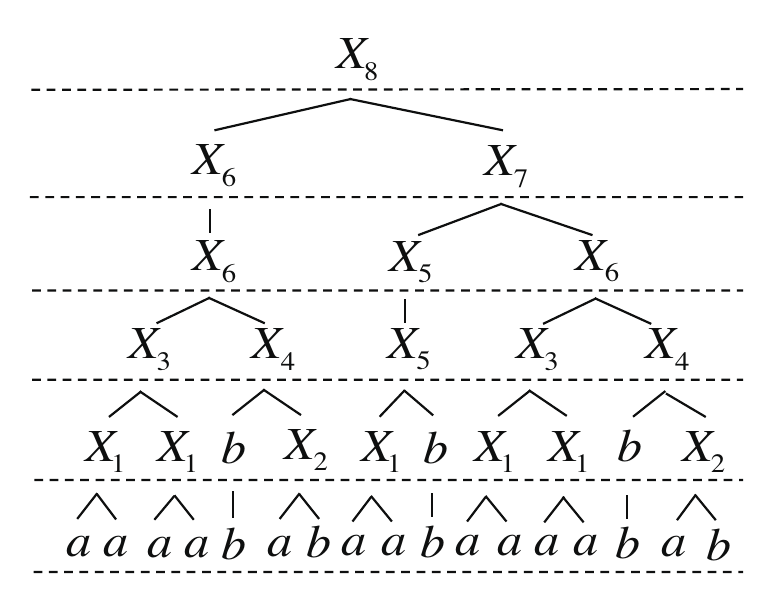
Figure 3. An example of a parse tree produced with our replacement